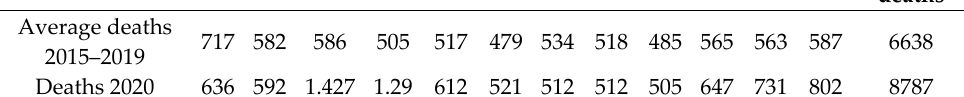
Figure 1. Per-month distribution of mortality events in 2020 and average number of deaths per-month in 2015–2019 period. Province of Pavia, Italy.